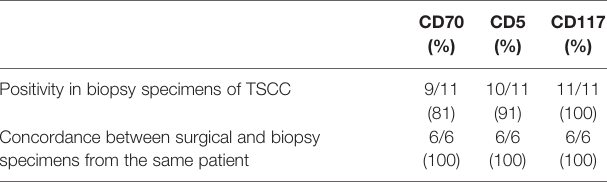
TABLE 3 | CD70, CD5, and CD117 immunostaining concordance between surgical and biopsy specimens.